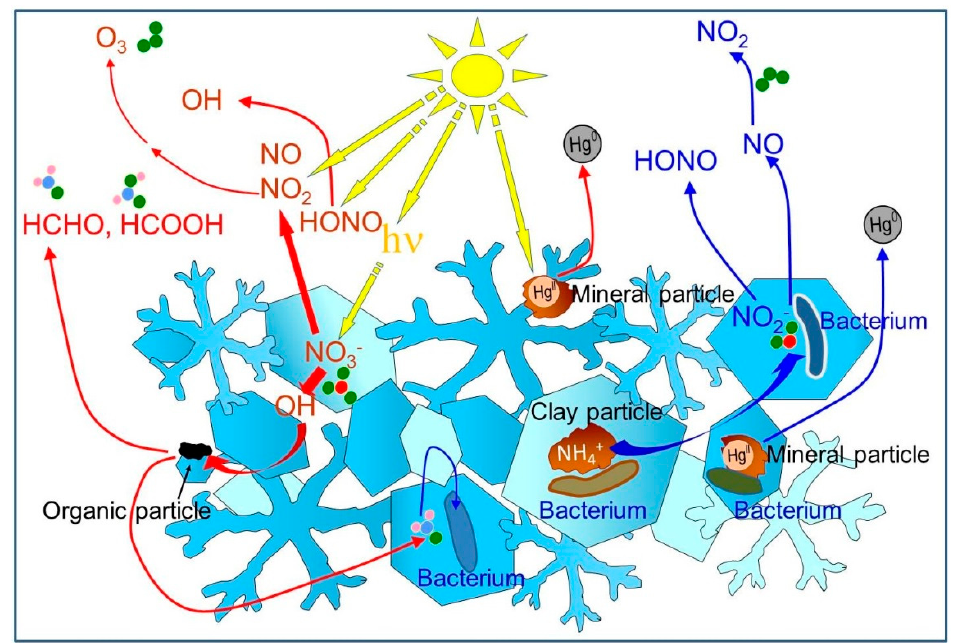
Figure 1. Selected observed and hypothetical modifications in snow and atmospheric composition due to photochemistry (red arrows) and microbial metabolism (blue arrows). Photochemical reactions photolyze the nitrate ion, producing NO, NO 2 , and HONO. Secondary chemistry produces OH, which can oxidize organics present on organic particles [7]. This chemistry releases NO, NO 2 , HONO, HCHO, and other organics to the atmosphere [18,28]. HCHO can form a solid solution with ice [34], thus becoming incorporated within snow crystals. Photochemistry reduces Hg II to Hg 0 , which is released to the atmosphere [17]. Gammaproteobacteria also reduce Hg II to Hg 0 [16]. The nitrifying bacterium Nitrosomonas produces NO 2 − from NH 4 + contained in clay mineral particles deposited onto snow by wind. Under suitable pH conditions (snow is often acidic), NO 2 − can be released to the atmosphere as HONO. The denitrifying bacterium Pseudomonas stutzeri produces NO from NO 2 − [6]. Nitrosomonas can also denitrify and produce NO. NO can be oxidized to NO 2 by atmospheric ozone. As suspected from ice core analyses [35], bacteria embedded within the ice lattice may also